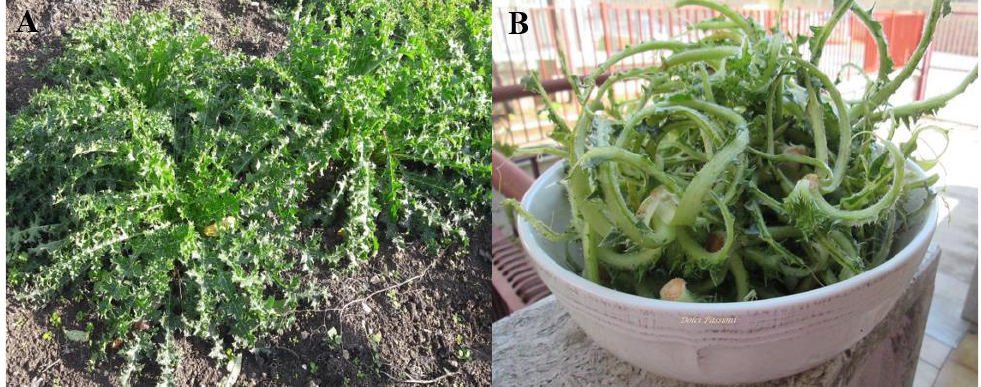
Figure 1. ( A ) Golden thistle in field; ( B ) the edible parts of the plant: midribs (central leaf veins). (image ( B ): Credits: https://dolcipassioni.net/wp-content/uploads/2021/04/mar283-2.jpg, accessed on 20 March 2023).